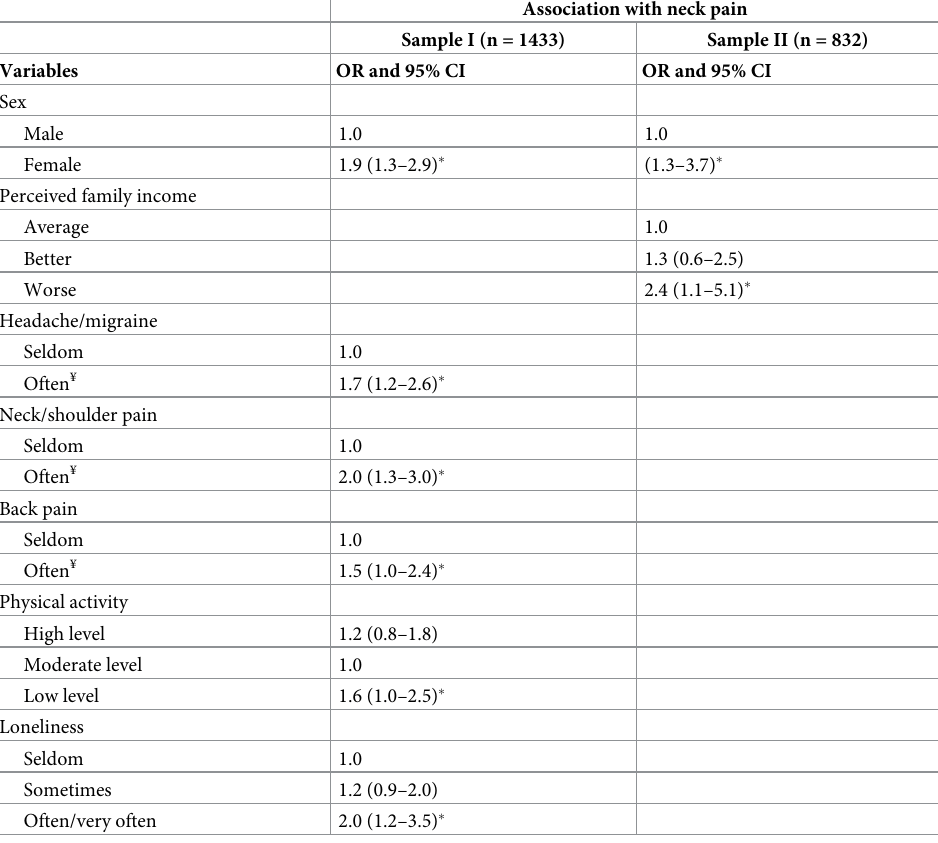
Table 2. Multiple analysis of the association between potential risk factors in adolescence and persistent neck pain in young